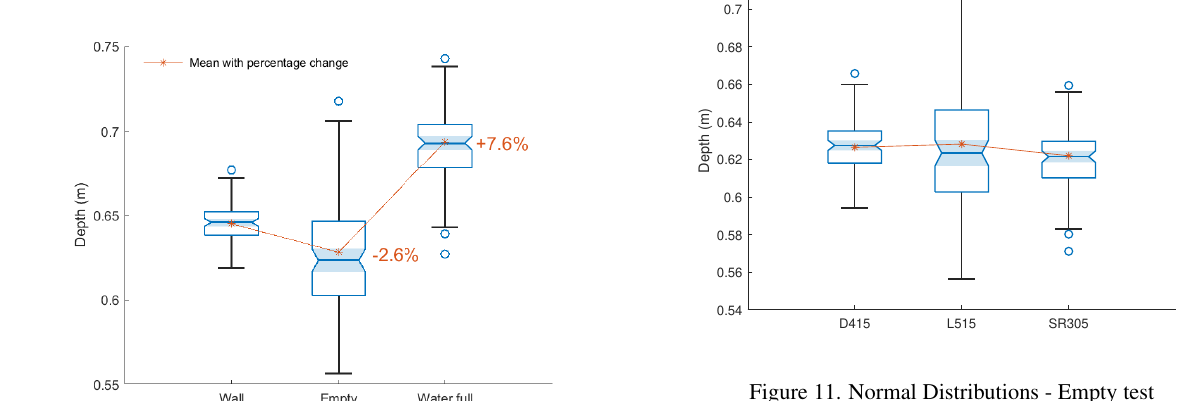
Figure 11. Normal Distributions - Empty test test. The central tendency of the three cameras changes signi- Figure 8. Normal Distributions - L515 ficantly. The mean value for D415 changes to 0.56 m, trans- lating into a percentage change of − 13% relative to the refer- ence value ( Wall test). On the other hand, the mean for L515 increases, having a percentage change of +7% . This increase results in an unrealistic mean value of depth estimates of